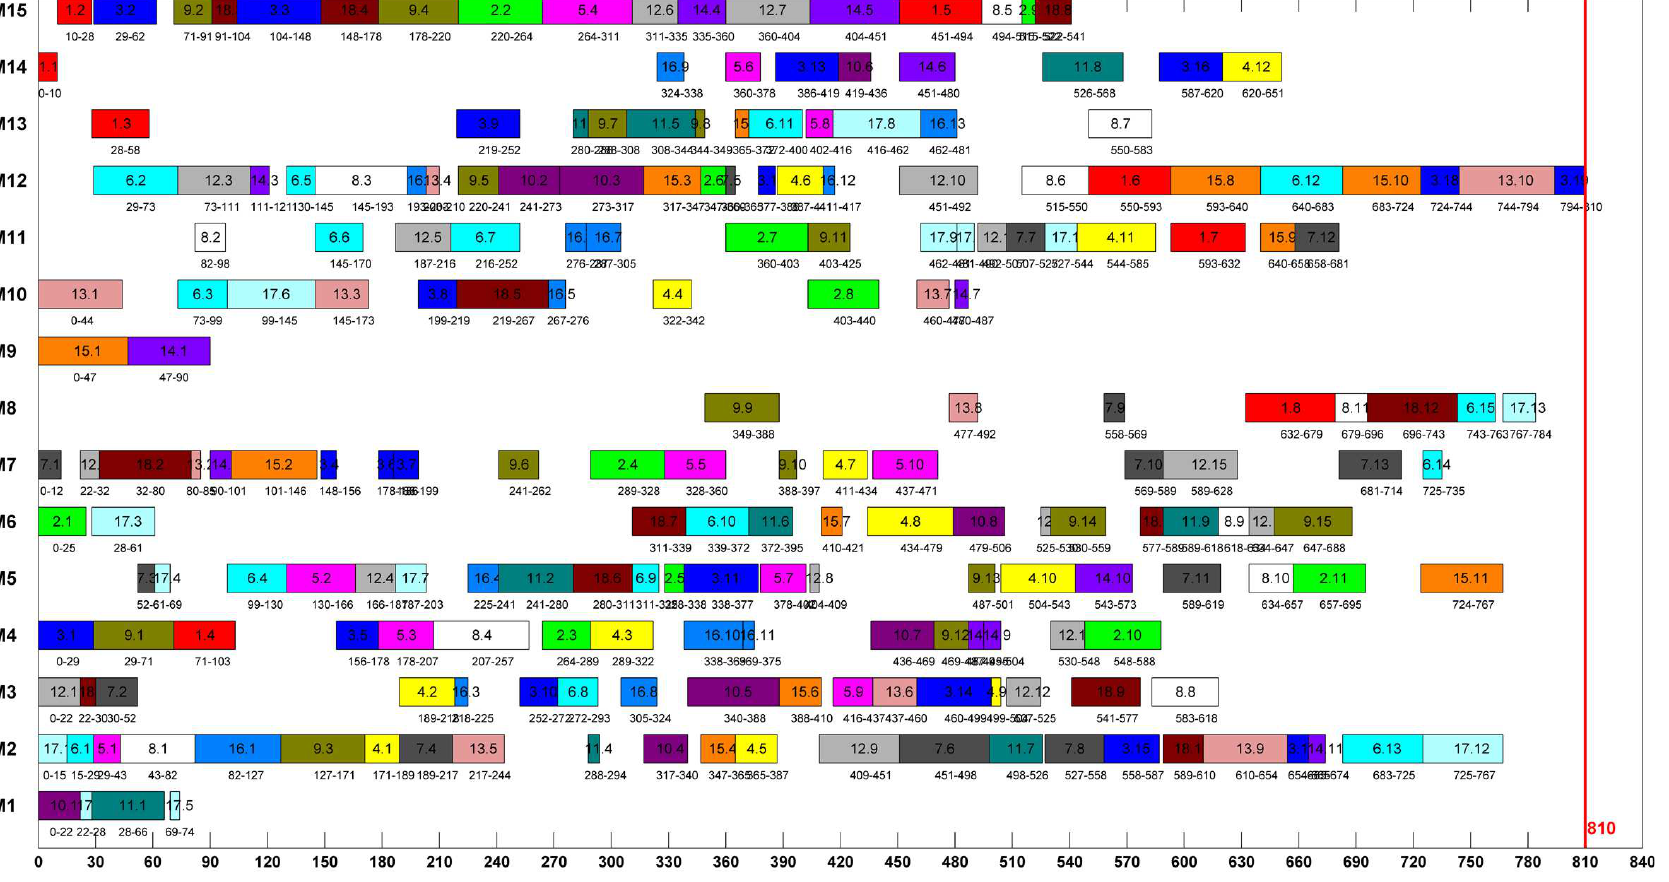
Figure 8. The Gantt chart that mainly considers the energy consumption (carbon emission)